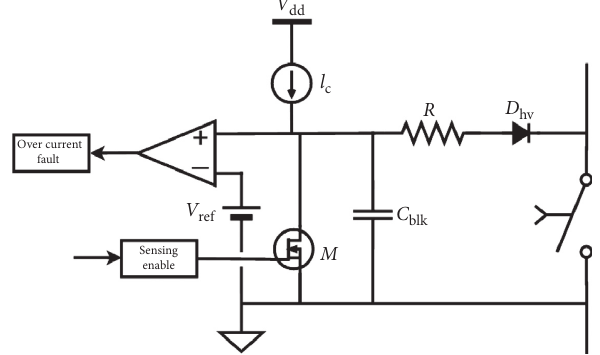
Figure 10: A desaturation circuit using constant current source.